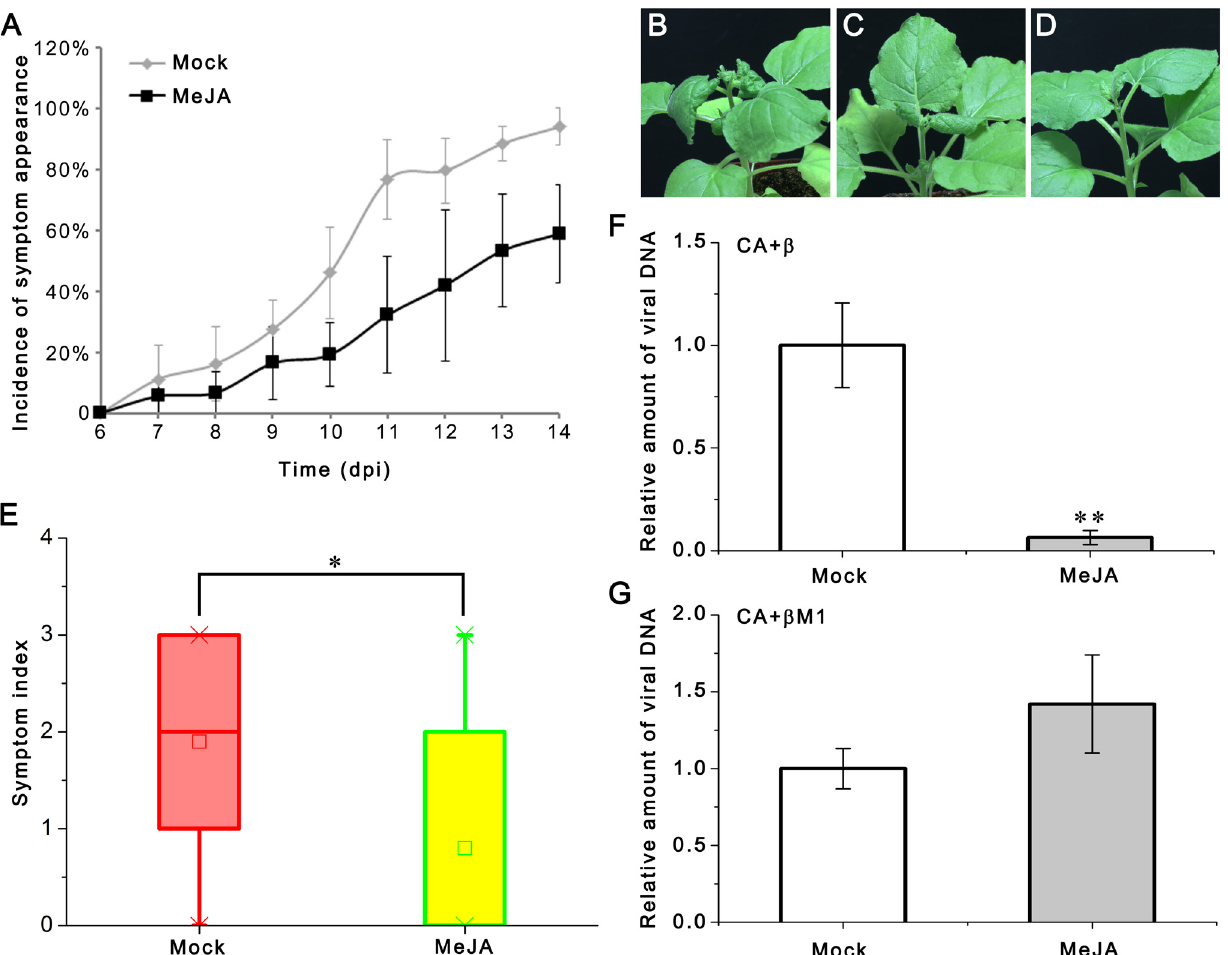
Fig 8. JA treatment enhances plant defense against CLCuMuV. (A) Exogenous MeJA treatment delayed the incidence of symptom appearance. Six- to seven-week-old N . benthamiana (10 – 12 plants per treatment) were agroinoculated with CA+ β , treated every other day with 50 μ M MeJA or mock solution (ethonal), and recorded for the symptom appearance until 14 dpi. Means came from three independent experiments, Error bars represent SEM. (B-D) Different levels of symptoms (B: the 4 th level, C: the 2 nd level, and D: level 0 showing no symptom). (E) Exogenous MeJA treatment attenued disease symptoms level. Plants were scored for the appearance of symptoms at 14 dpi. (F) Total DNA was extracted from each plant respectively and subjected to real-time PCR (means ± SEM, n = 7) to quantify viral DNA accumulation at 14 dpi. (G) Six- to seven-week-old N . benthamiana (10 plants per treatment) were agroinoculated with CA+ β M1, treated every other day with 50 μ M MeJA or mock solution (ethonal), Total DNA was extracted from each plant respectively and subjected to real-time PCR (means ± SEM, n = 7) to quantify viral DNA accumulation at 14 dpi. The internal reference method was used to calculate the relative amount of viral DNA. The raw data of (E, F and G) were analysed by two-sample t -test to show significance level at 0.05 ( * ) and 0.01 ( ** ). These experiments were repeated at least